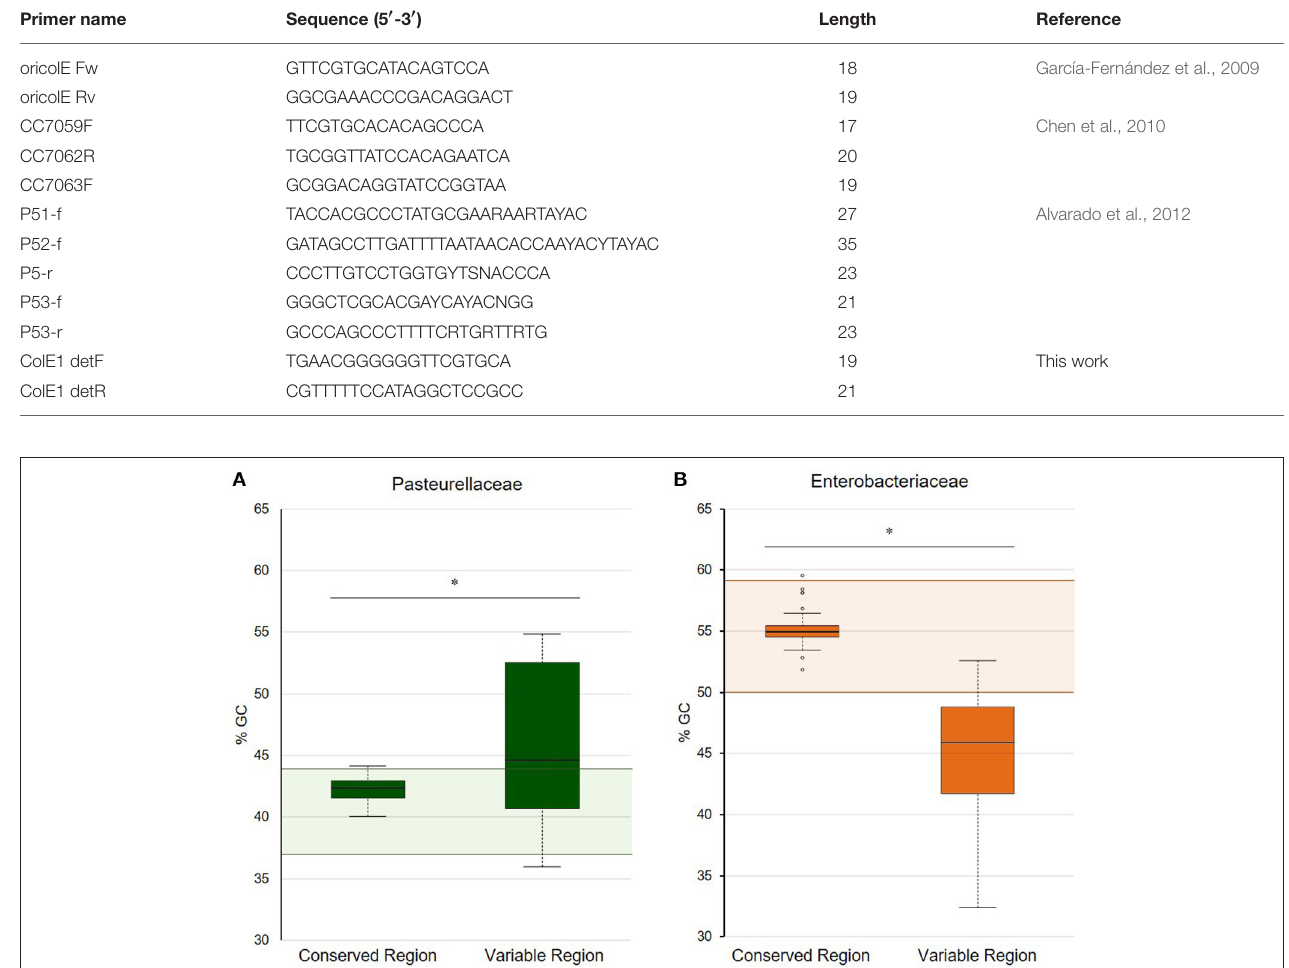
FIGURE 6 | GC content of the conserved and variable regions of ColE1 plasmids. Representation of the percentage of GC content in both the conserved and variable region of ColE1 plasmids in Pasteurellaceae (A) and Enterobacteriaceae (B). Colored boxplots represent the GC content of each of the ColE1 replicons studied. The shaded areas correspond to the %GC range of the genomes analyzed of these two bacteria families (Supplementary Tables S1, S2). The asterisks indicate the difference of the mean values of GC content between the conserved and variable region in both families of bacteria [ t (24) = 2.91, P < 0.05 and t (41) = 10.83, P < 0.05,